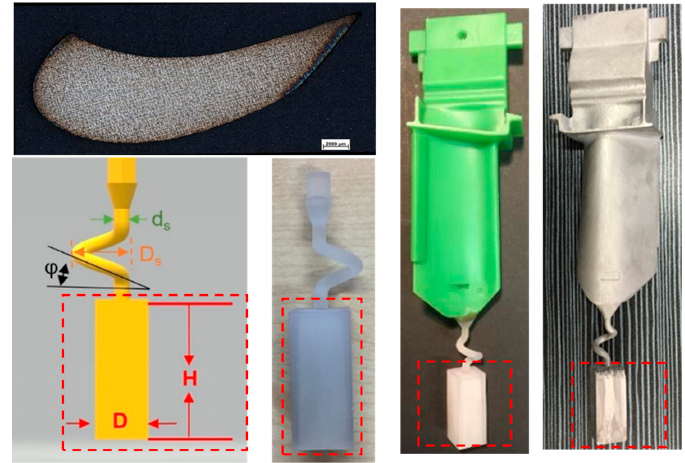
Figure 9. Schematic flow-process diagram of single crystal (SX) turbine blade investment casting with optimized starter block parameters (D = 10 mm and H = 30 mm).